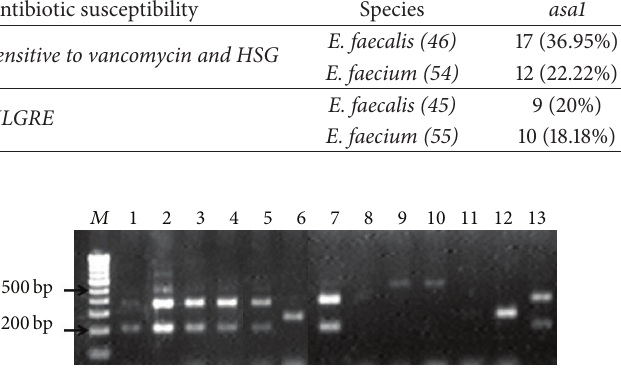
Figure 1: Gel electrophoresis showing virulence genes in the